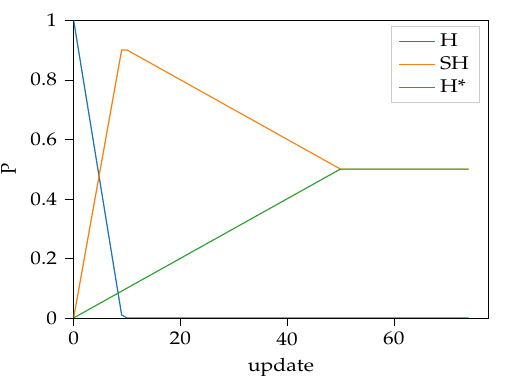
Figure 3. Sample behavior of the proposed probability annealing algorithm for step SH = 0.1, step H ∗ = 0.01 and H ∗ max = 0.5. Initial P is [ 1,0,0 ] for random hard, semi-hard, and hardest negative sampling,